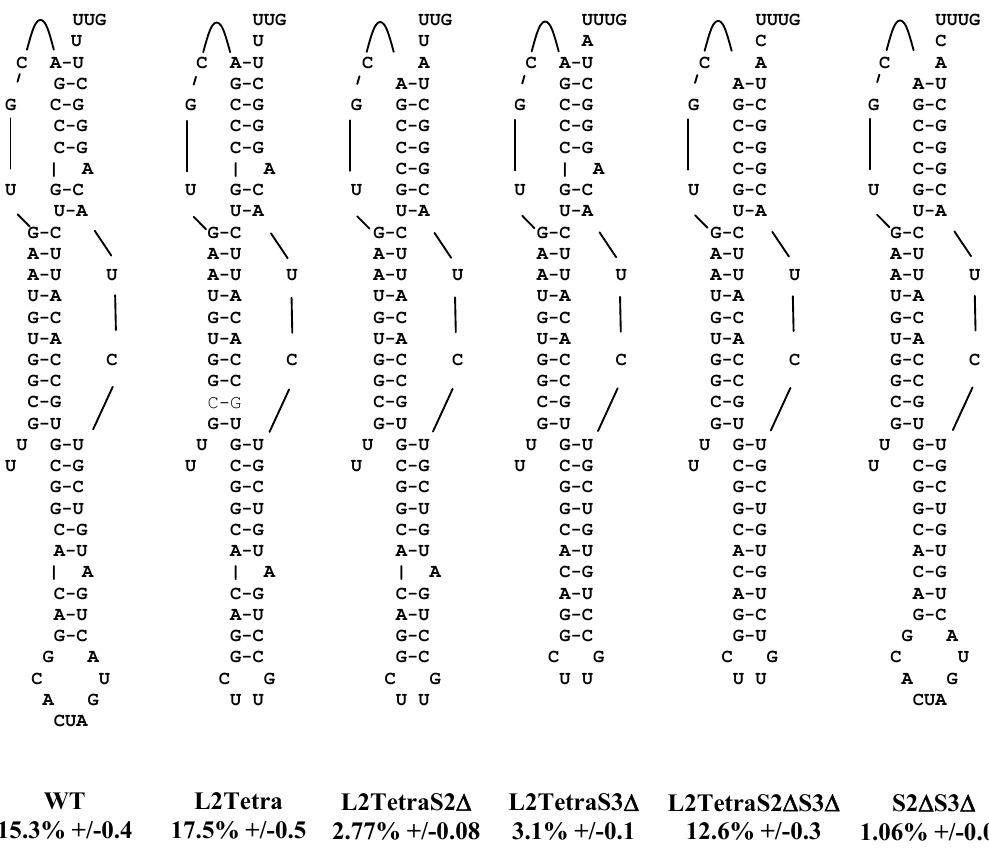
Figure 2. Stabilizing stem 3 with a tetraloop preserves -1 PRF efficiency. Site directed mutagenesis was used to change loop2 of the wild-type SARS pseudoknot into tetraloop (L2Tetra from Figure 1). The bulged adenosines in stems 2 and 3 were removed by site directed mutagenesis singly or together in conjunction with the tetraloop (L2TetraS2 Δ , L2TetraS3 Δ , and L2TetraS2 Δ S3 Δ ). Both bulged adenosines were removed from the wild-type pseudoknot (S2 Δ S3 Δ ). Frameshifting efficiency is expressed as a percentage with standard error as described in the experimental